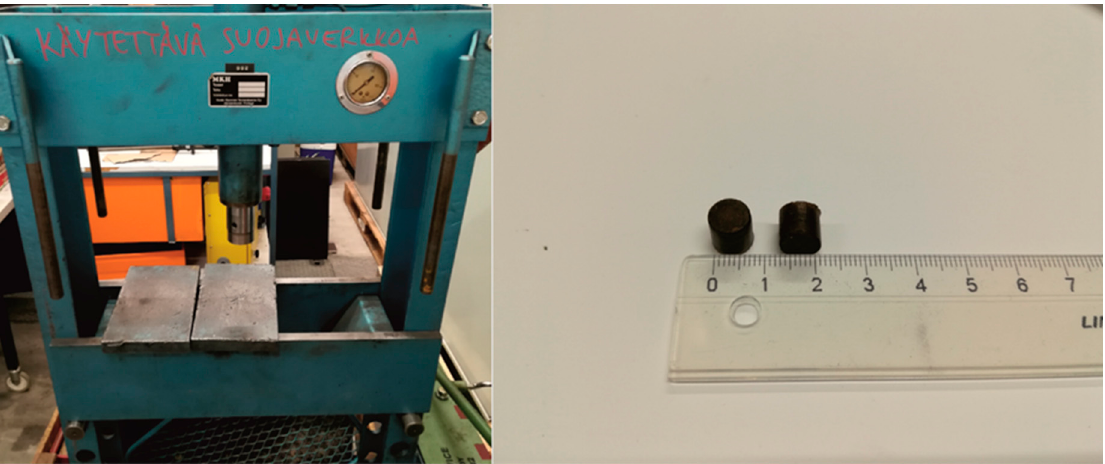
Figure 1. Hydraulic press and lignin briquettes.